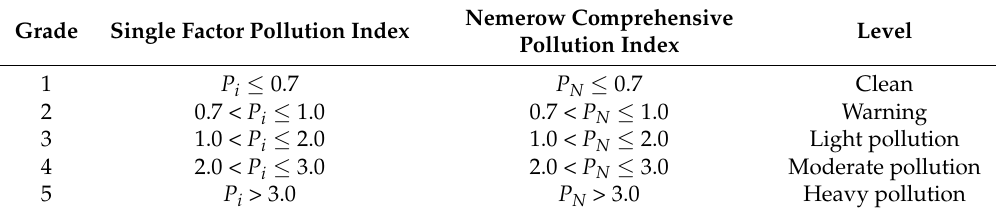
Table 2. Grading standard for soil pollution of arsenic and